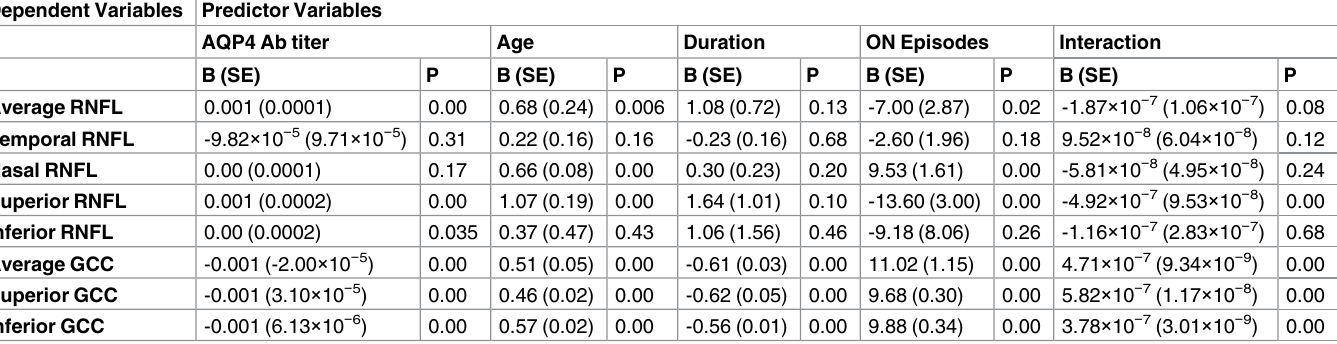
Table 6. Generalized Estimating Equation Regression Analysesfor Optical Coherence Tomography Parameters in Aquaporin-4 Antibody-Positive Eyes. Dependent Variables Predictor